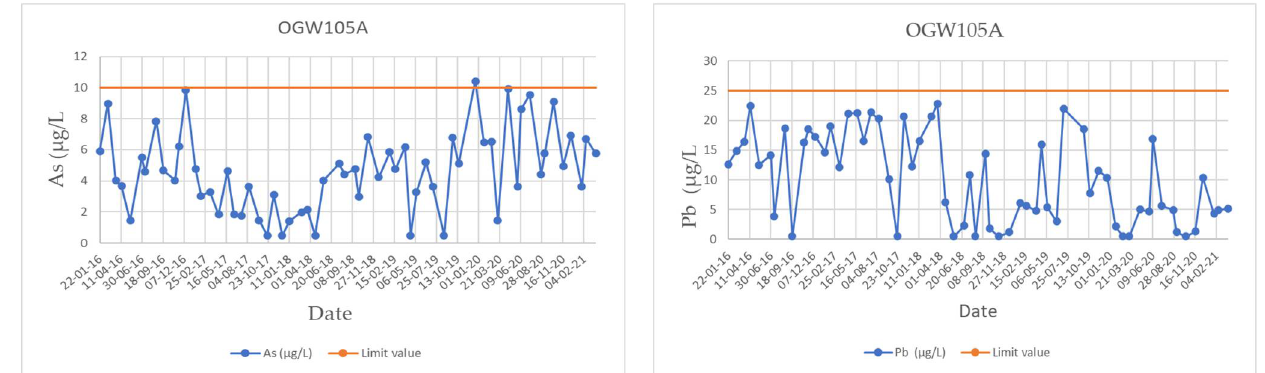
Figure 10. As and Pb in ground waters vs. time 750 m downstream of the old Olympias arsenopy- rites concentrate storage area (OGW105A monitoring